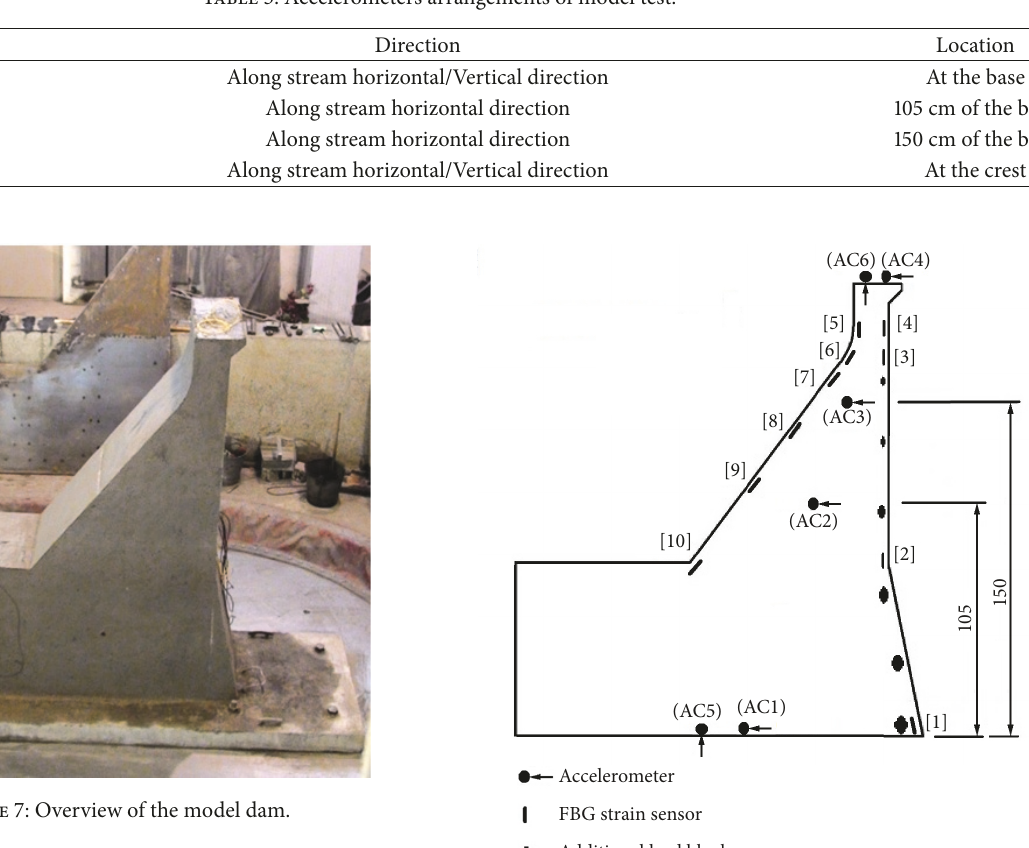
Table 5: Accelerometers arrangements of model test.